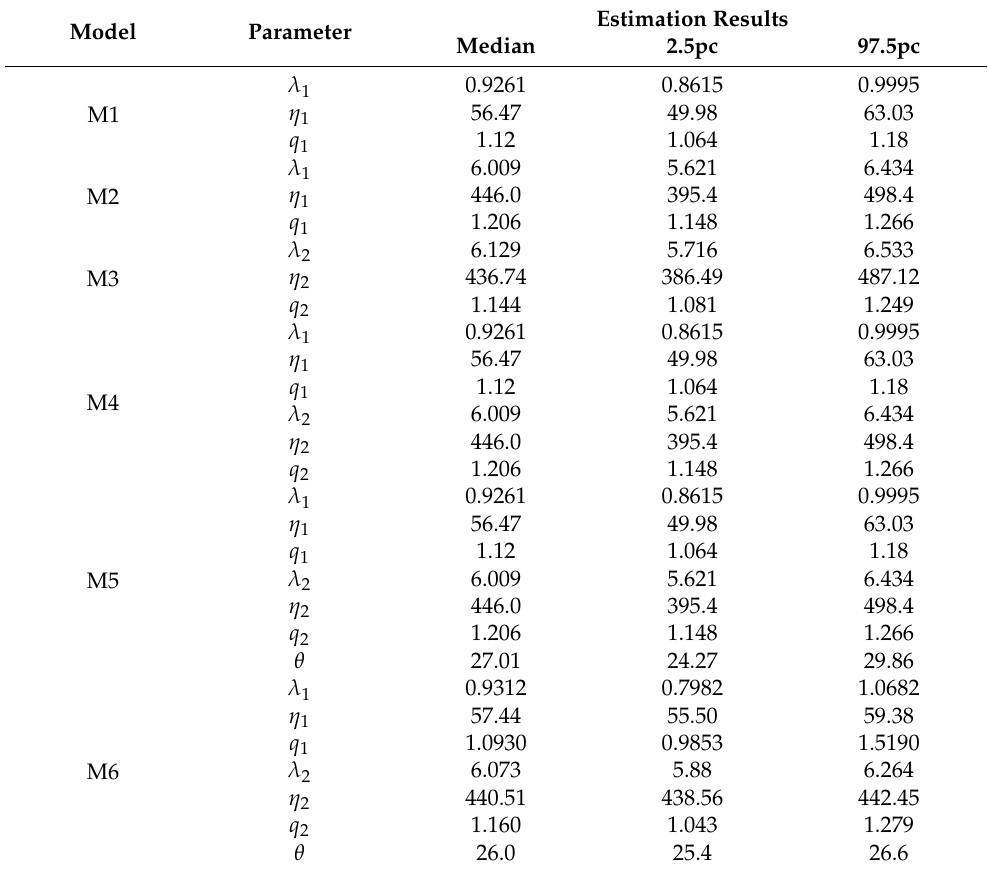
Table 6. Parameter estimation results.